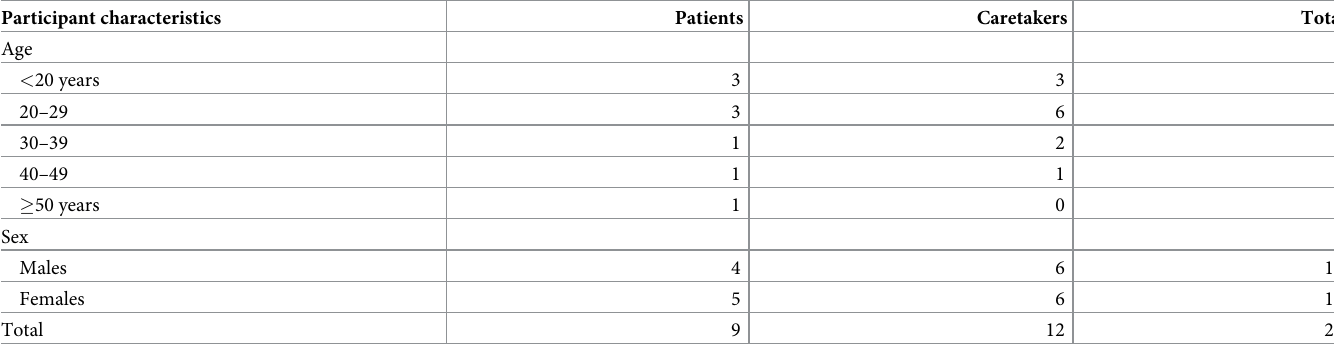
Table 1. Characteristics of patient and caretaker interview participants (n = 21). Participant